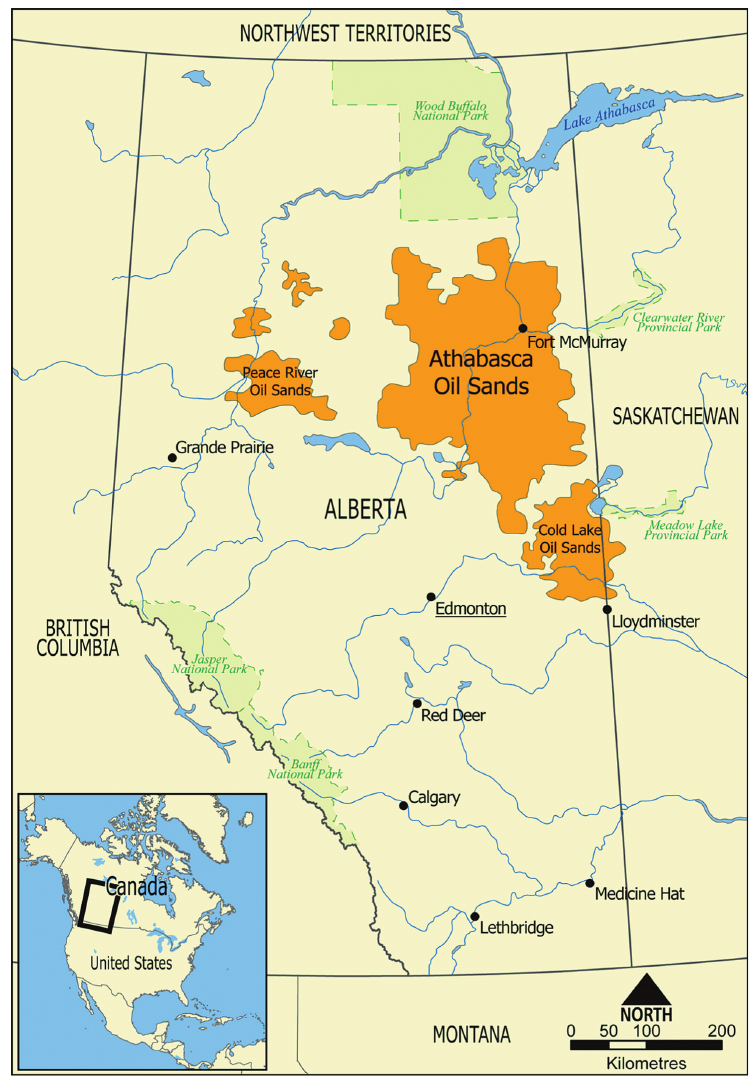
Figure 3. Map of oil sands in Alberta. Map: © Norman Einstein